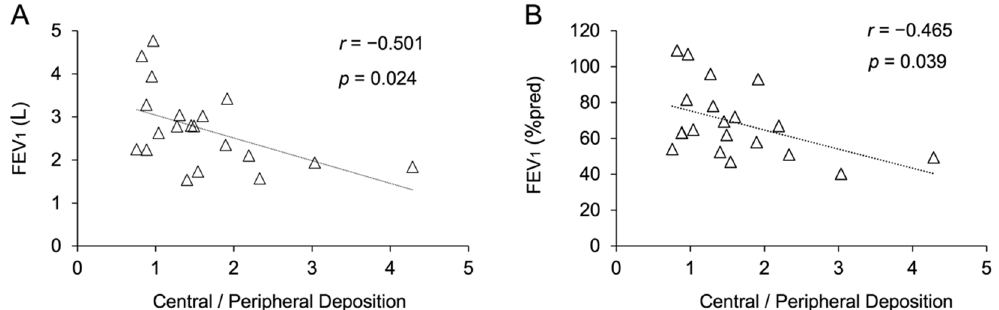
Figure 5. ( A ) Correlation between the forced expiratory volume in 1 s (FEV 1 ) and the central-to-peripheral deposition ratio. ( B ) Correlation between the FEV 1 compared to the FEV 1 of the reference population (FEV 1 (%pred)) and the central-to-peripheral deposition ratio.